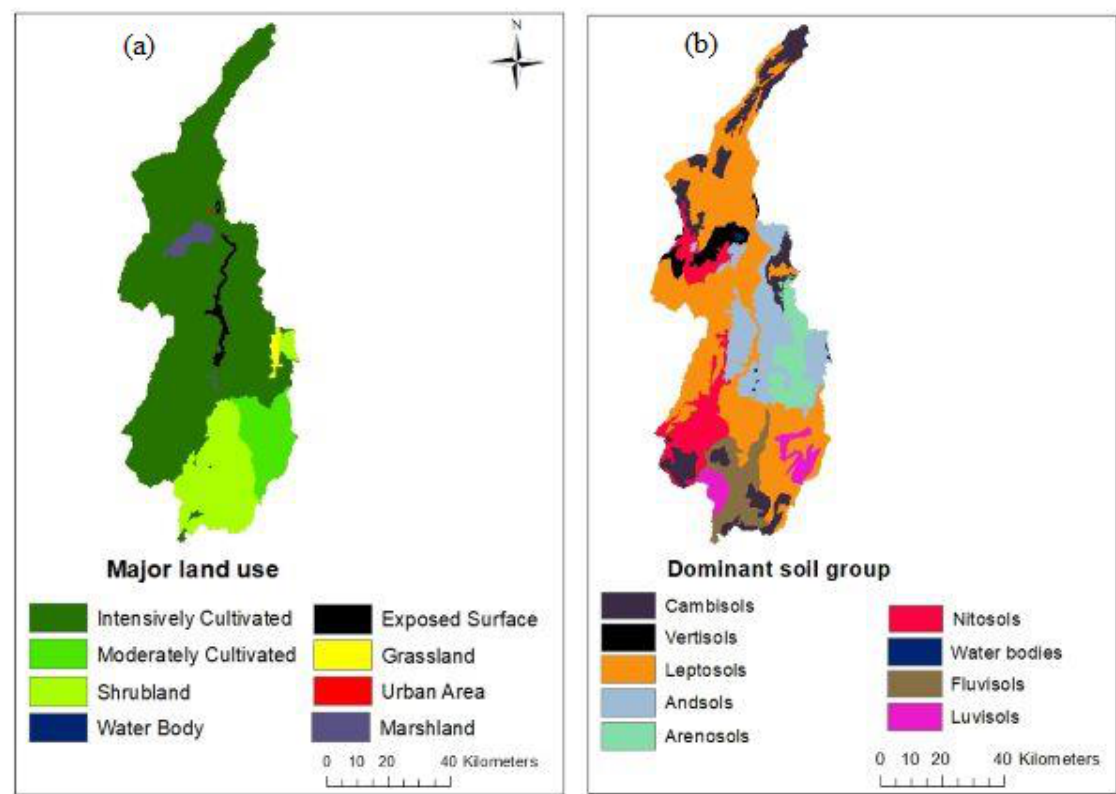
Figure 2. ( a ) Land use. ( b ) Dominant soil-group. Table 1. Collected